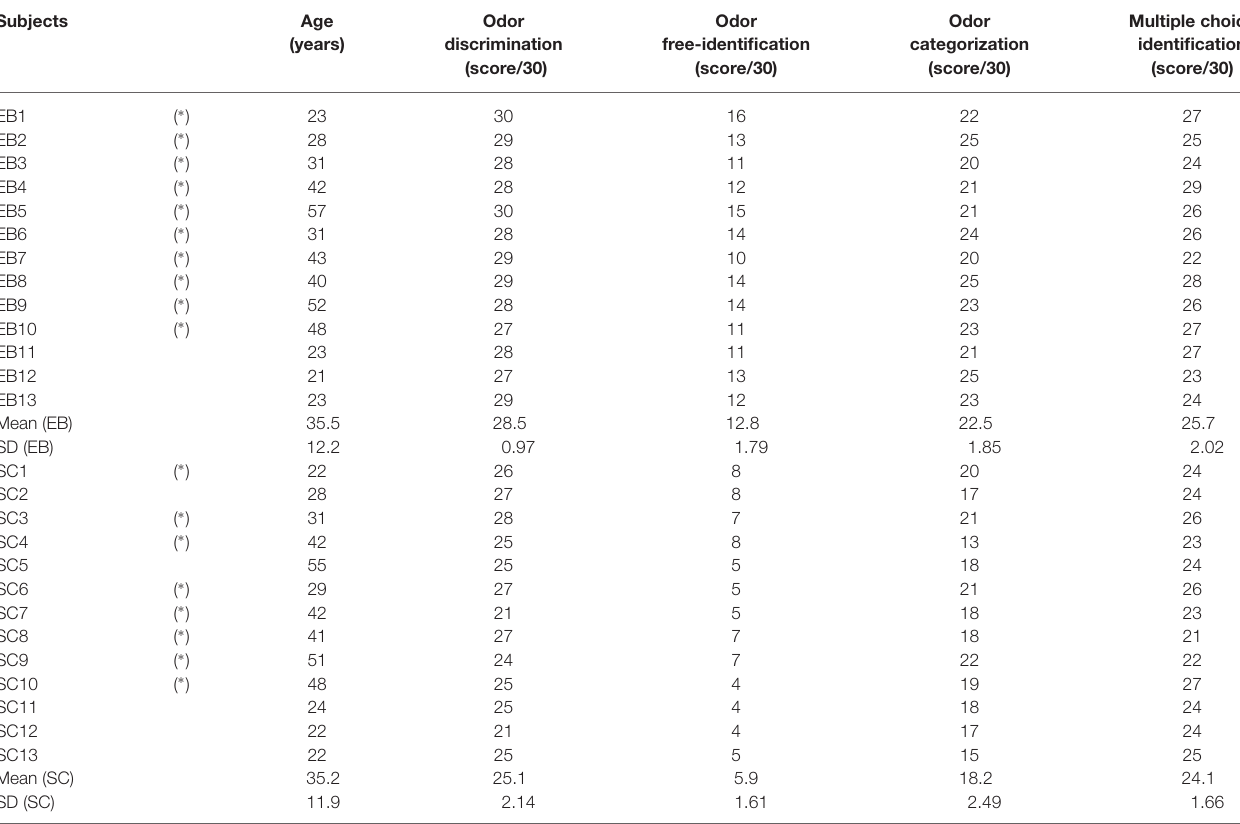
TABLE 1 | Results from behavioral experiment in blind and sighted subjects (Cuevas et al., 2009). Subjects